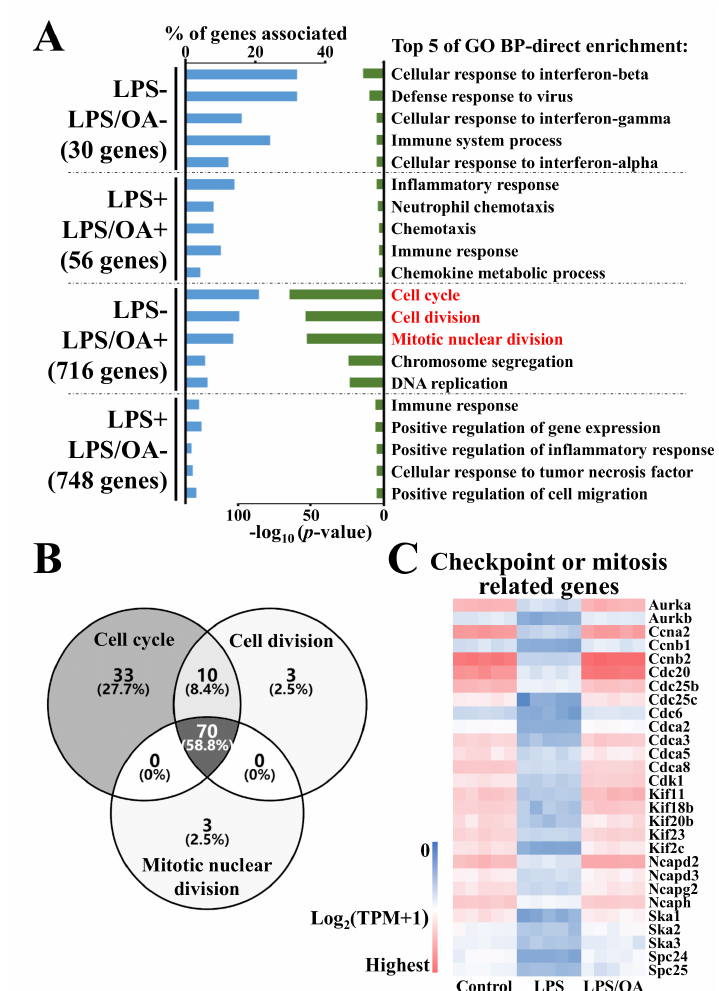
Figure 6. Cell cycle related process is the most obvious in GO analysis of the RNA-seq results. (A) List of top 5 enriched processes in the GO analysis. Red color highlighted processes with the most p value in the analysis. (B) Venn diagram of genes related with the three most enriched processes including cell cycle, cell division, mitotic nuclear division. The percentage of gene enclosed in each catalog was enclosed in the bracket. (C) Expression profiles of checkpoint and/or mitosis related